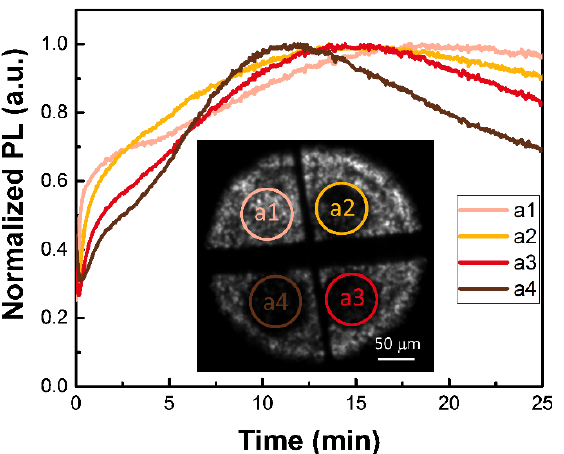
Figure 5. PL responses of the four areas with gradually increasing defect concentration in the mix- ture of O 2 and acetone. The inset shows the PL image of four areas (a1–a4) whose PL levels gradually decreased after BQ vapor treatment for different irradiation durations. Only the circled regions were treated under laser irradiation.